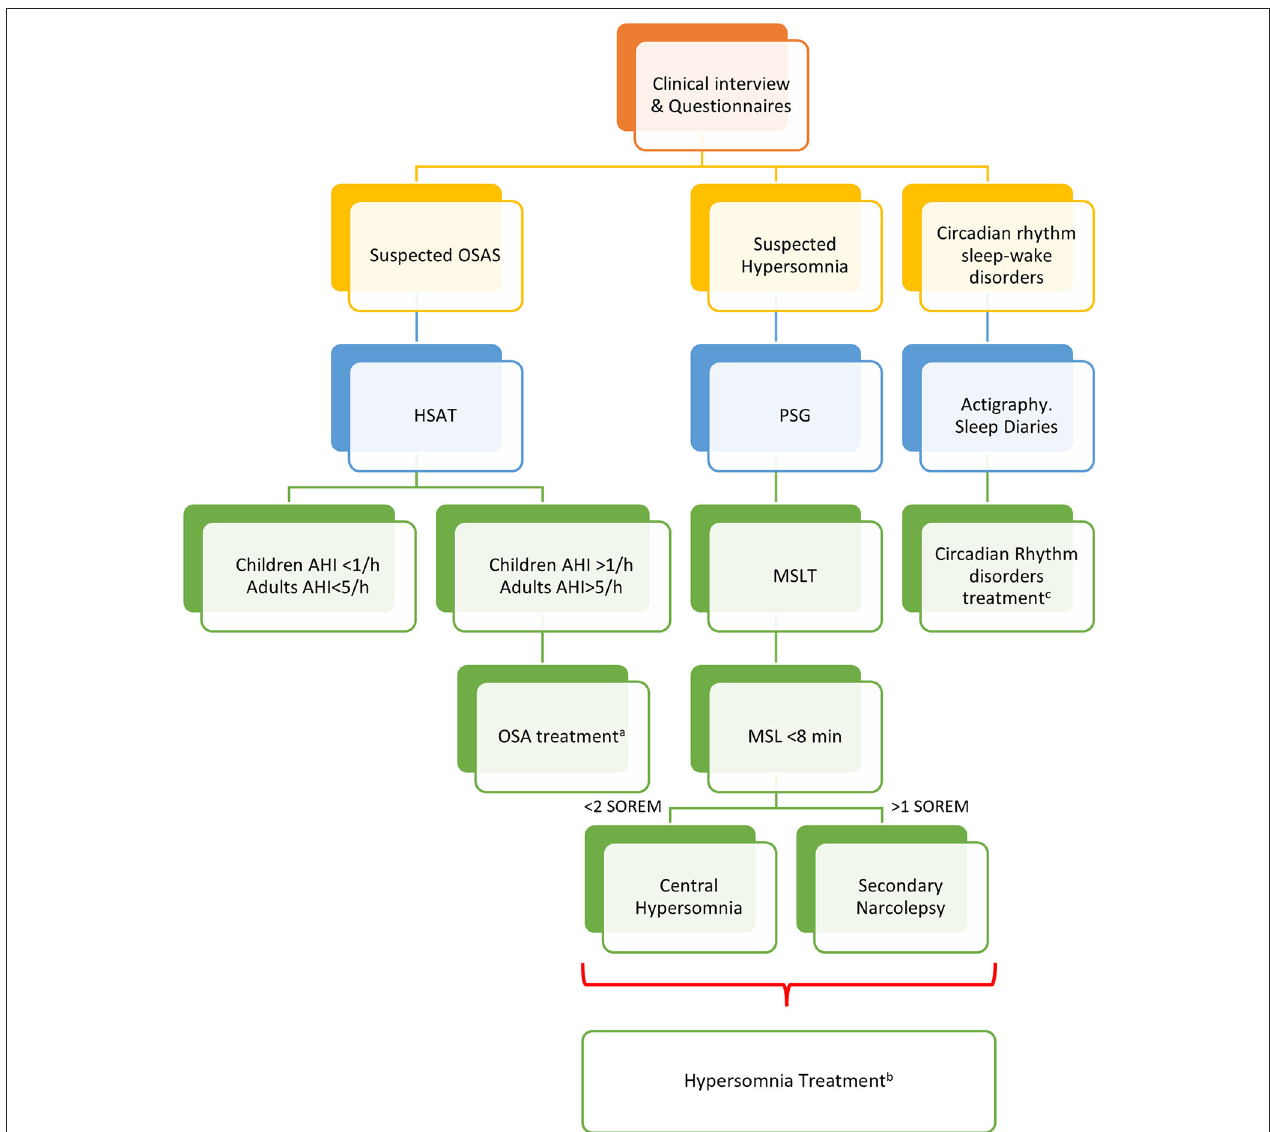
FIGURE 2 | Algorithm for the management of sleep disorders in patients with CP. PSG, polysomnography; OSAS, Obstructive Sleep Apnea (OSA) syndrome; HSAT, home sleep apnea test; AHI, apnea-hypopnea index per hour of sleep; MSLT, multiple sleep latency test; MSL, mean sleep latency; a The management of OSA should include weight loss, avoidance of alcoholic intake and smoking, sleep hygiene, and positional therapy. Positive Airway Pressure (PAP) is considered first-line treatment. Oral appliances may be suggested for mild to moderate OSA and surgery to correct anatomic obstructions (66). b The treatment of central hypersomnias and secondary narcolepsy should include cognitive behavioral therapy (CBT) and approved stimulants (i.e., modafinil, pitolisant, solriamfetol, and sodium oxybate) (67). c Sleep hygiene, CBT, and short-term pharmacologic approach should be considered for insomnia and CRSWD